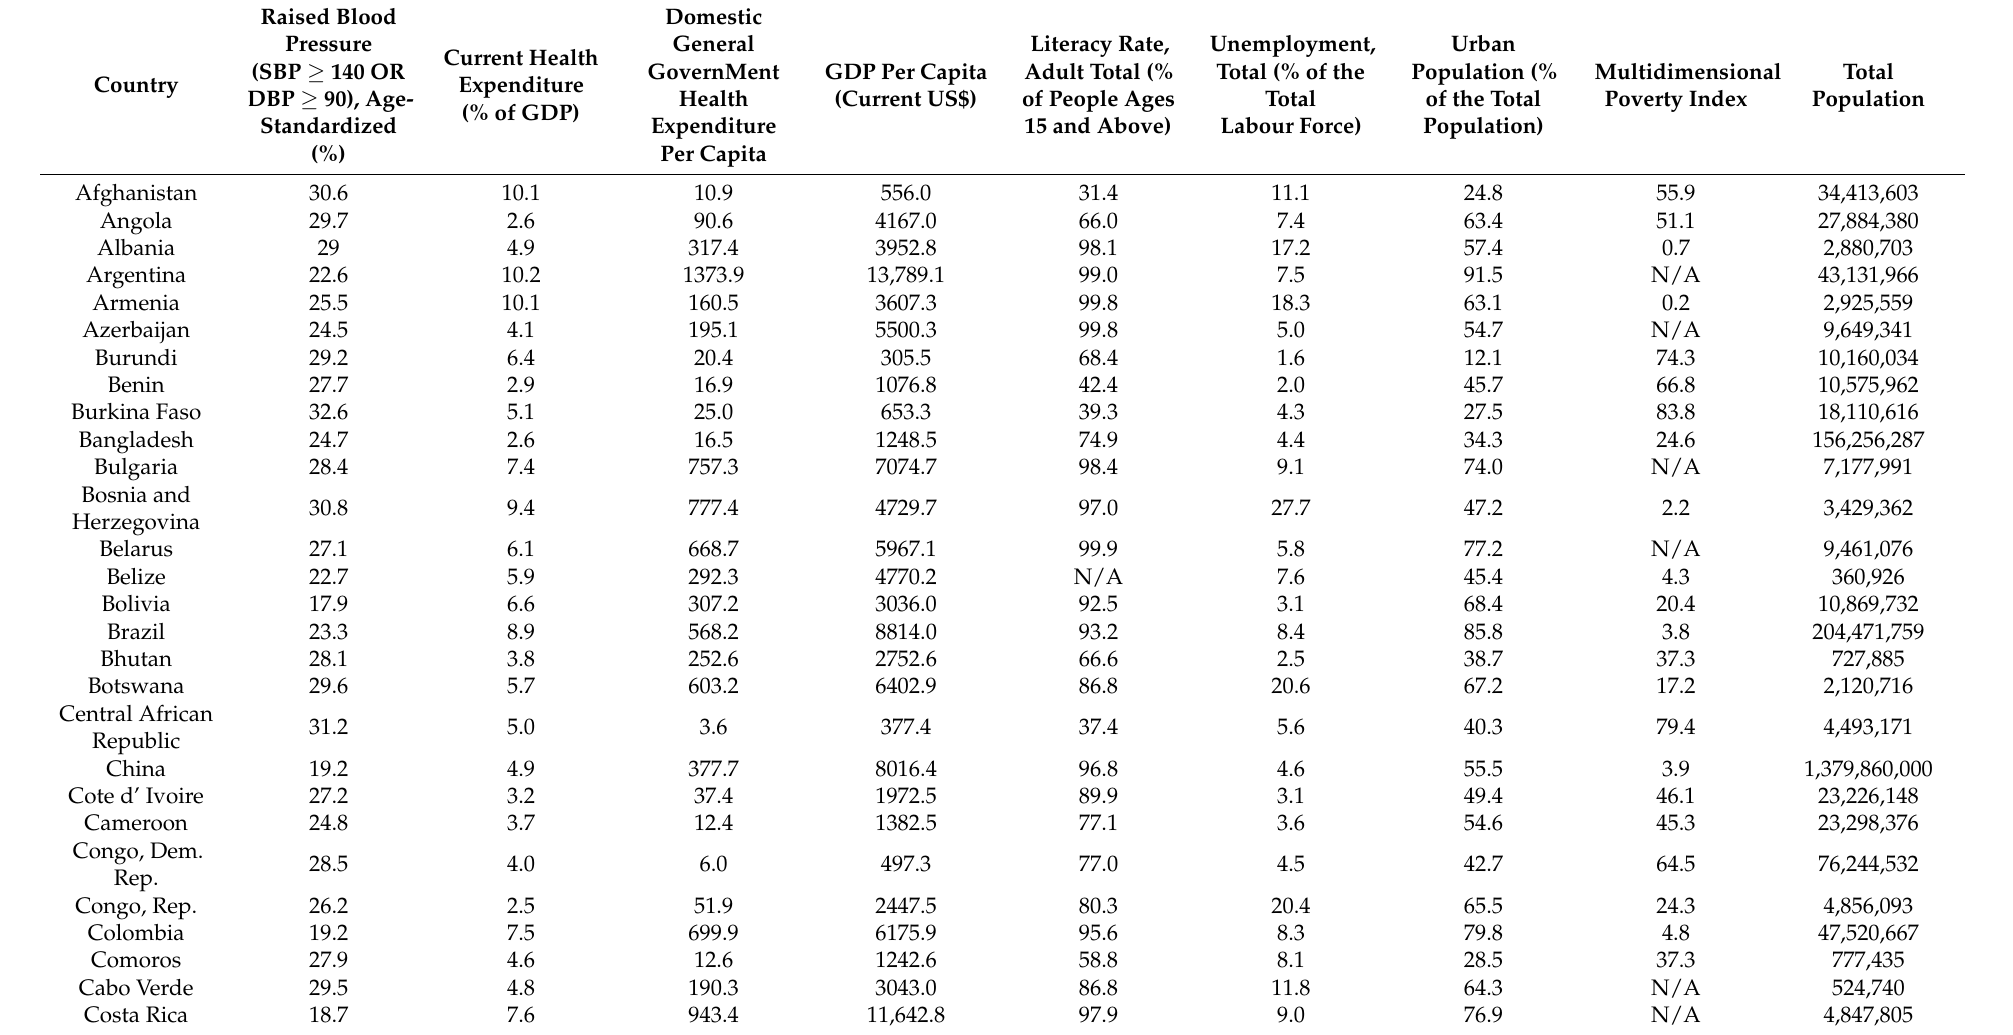
Table 1. Summary characteristics of variables included in the